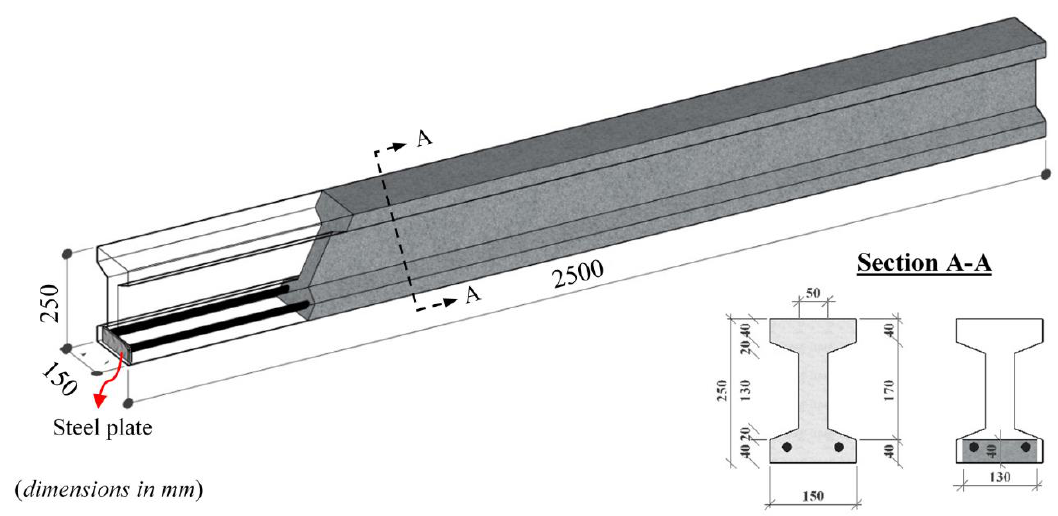
Figure 3. A typical singly reinforced concrete test beams.